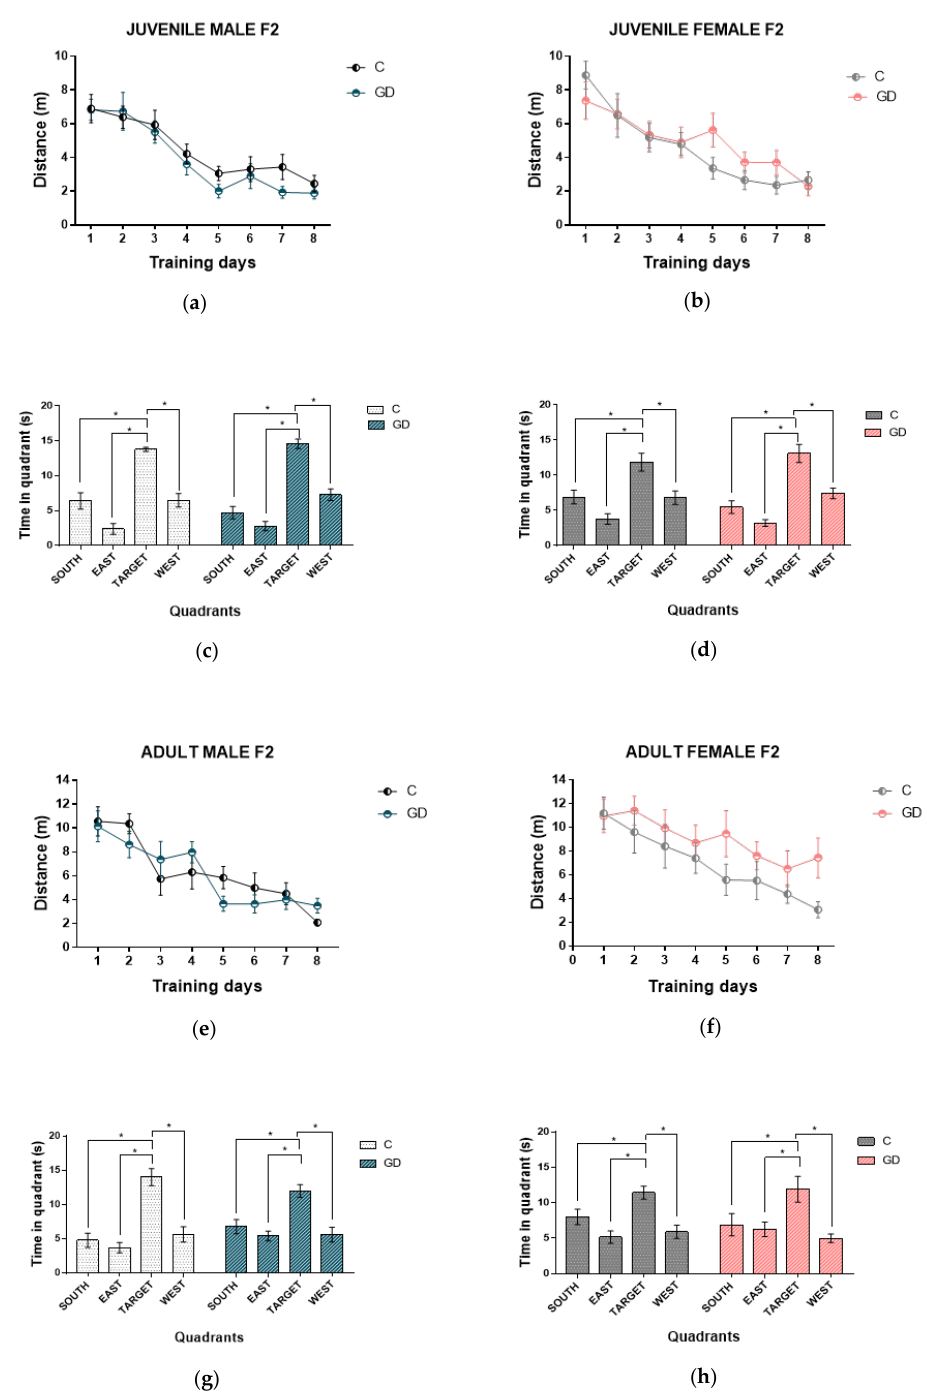
Figure 2. Effect of GD on spatial learning of the second-generation offspring. The distance traveled throughout the test days can be observed: male and female offspring of juvenile age ( a , b ) and the time they spent in each quadrant in the test ( c , d ). Distance traveled of the offspring in adulthood males and females ( e , f ) and the time in each quadrant of ( g , h ). C, offspring of control rats; GD, offspring of rats with gestational diabetes, n = 10 to 12. The data are expressed as the mean ± SEM. Two-way repeated-measures ANOVA, one-way ANOVA; Tukey’s post hoc, Student’s t -test, * p <